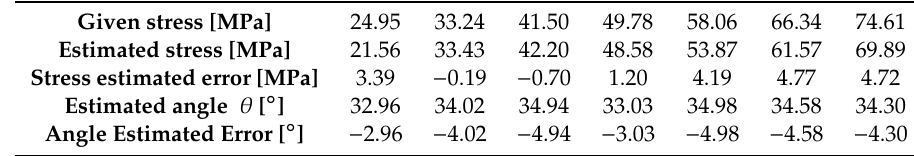
Table 6. Estimated results and errors for the hot-rolled specimen